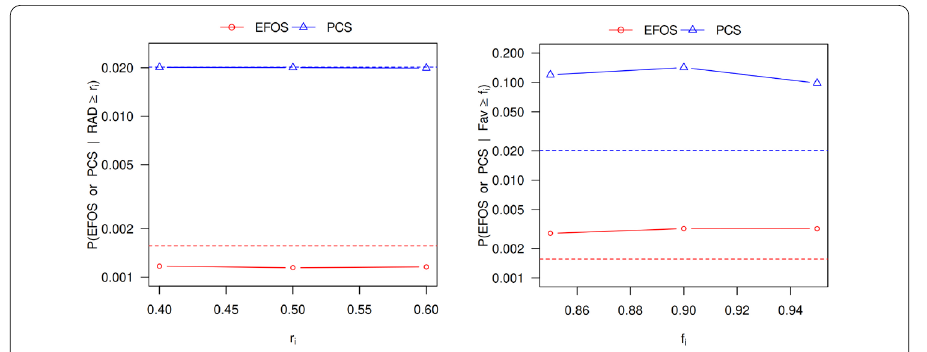
Figure 6 Second experiment. Probability for a contract to be corrupt (EFOS or PCS, solid lines) given it has an RAD ≥ r i ( Left ) or a Fav ≥ f i ( Right ), for several values of the thresholds, r i = { 0.4,0.5,0.6 } and f i = { 0.85,0.9,0.95 } . The dashed lines correspond to the probability to find and EFOS (red) or PCS (blue) contract in the source